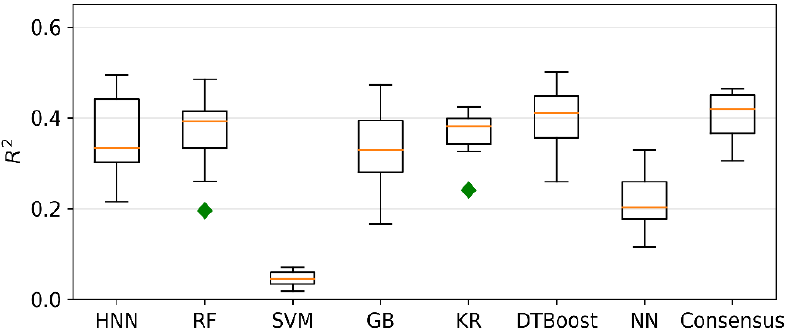
Figure 3. R 2 of regression models developed based on HNN-Cancer, RF, SVM, GB, KR, DTBoost, NN, and consensus methods.